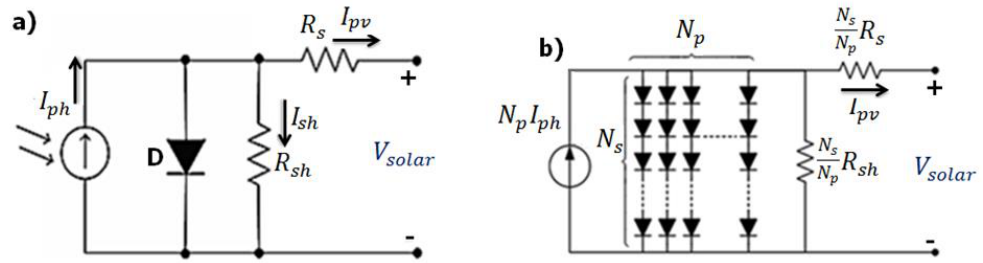
Figure2. Schematicrepresentationofthesolarcell. ( a )Simplifieddiagramofthesolarcell; ( b )Equivalent Figure 2. Schematic representation of the solar cell. ( a ) Simplified diagram of the solar cell; ( b ) diagram of the solar Equivalent diagram of the solar cell.